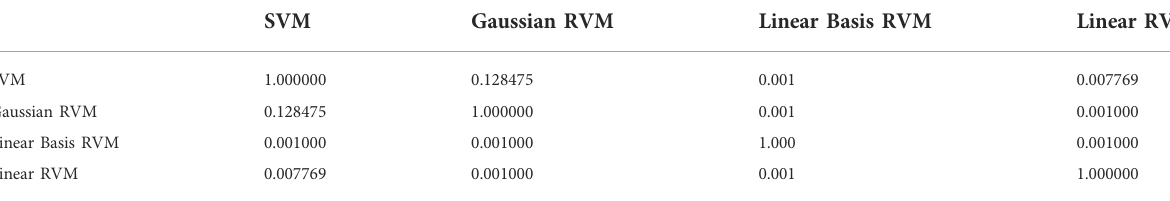
TABLE 2 Nemenyi test p -values for SVM and